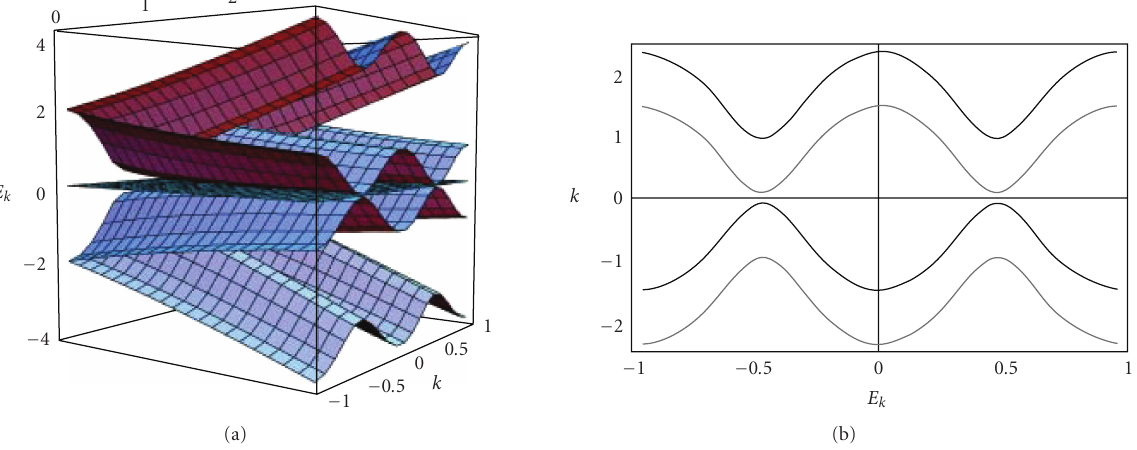
Figure 11: Energy bands of the decorated ladder model. (a) The energy bands as a function of V . (b) The snap shot of the energy bands when V = 1. k means the wavevector in units of π/s such that − 1 . 0 ≤ k ≤ 1 . 0, V means the π -electron hopping integral between the interchain sites, and E means the energy in units of V = 1. Here we have taken the values α = 0, β = 0, a = 0 . 9,and b = 1 . 2.